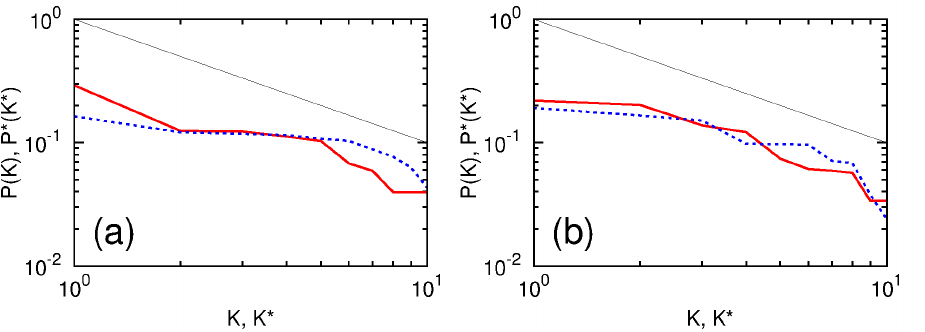
Figure 7. Dependence of probabilities of PageRank P (red) and CheiRank P (cid:2) (blue) on corresponding indexes K and K (cid:2) . The probabilities are obtained from the network and Google matrix of cultures shown in Fig. 5 and Fig. 6 for corresponding panels ( a ),( b ) . The straight lines indicate the Zipf law P * 1 = K ; P (cid:2) * 1 = K (cid:2) .